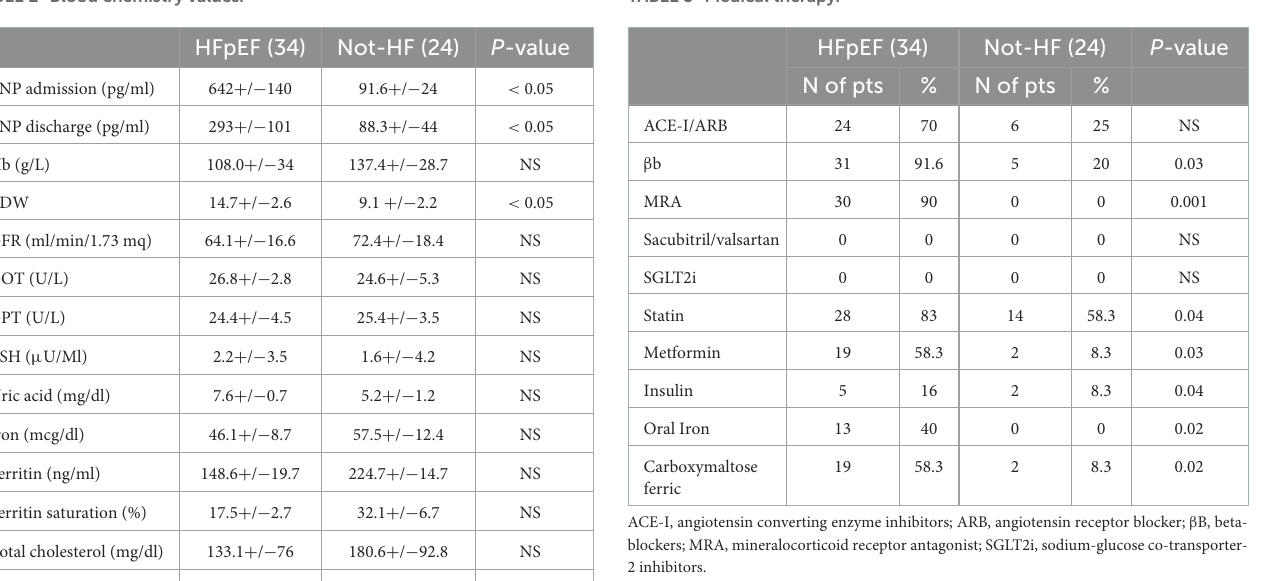
TABLE 2 Blood chemistry